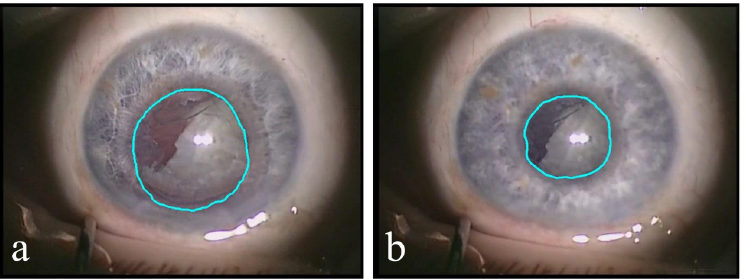
Fig 1. Example of pupil reaction from Dataset A. The cyan line shows the pupil segment, which significantly changes its size during the operation. A) The eye before pupil reaction. B) The eye after pupil reaction.